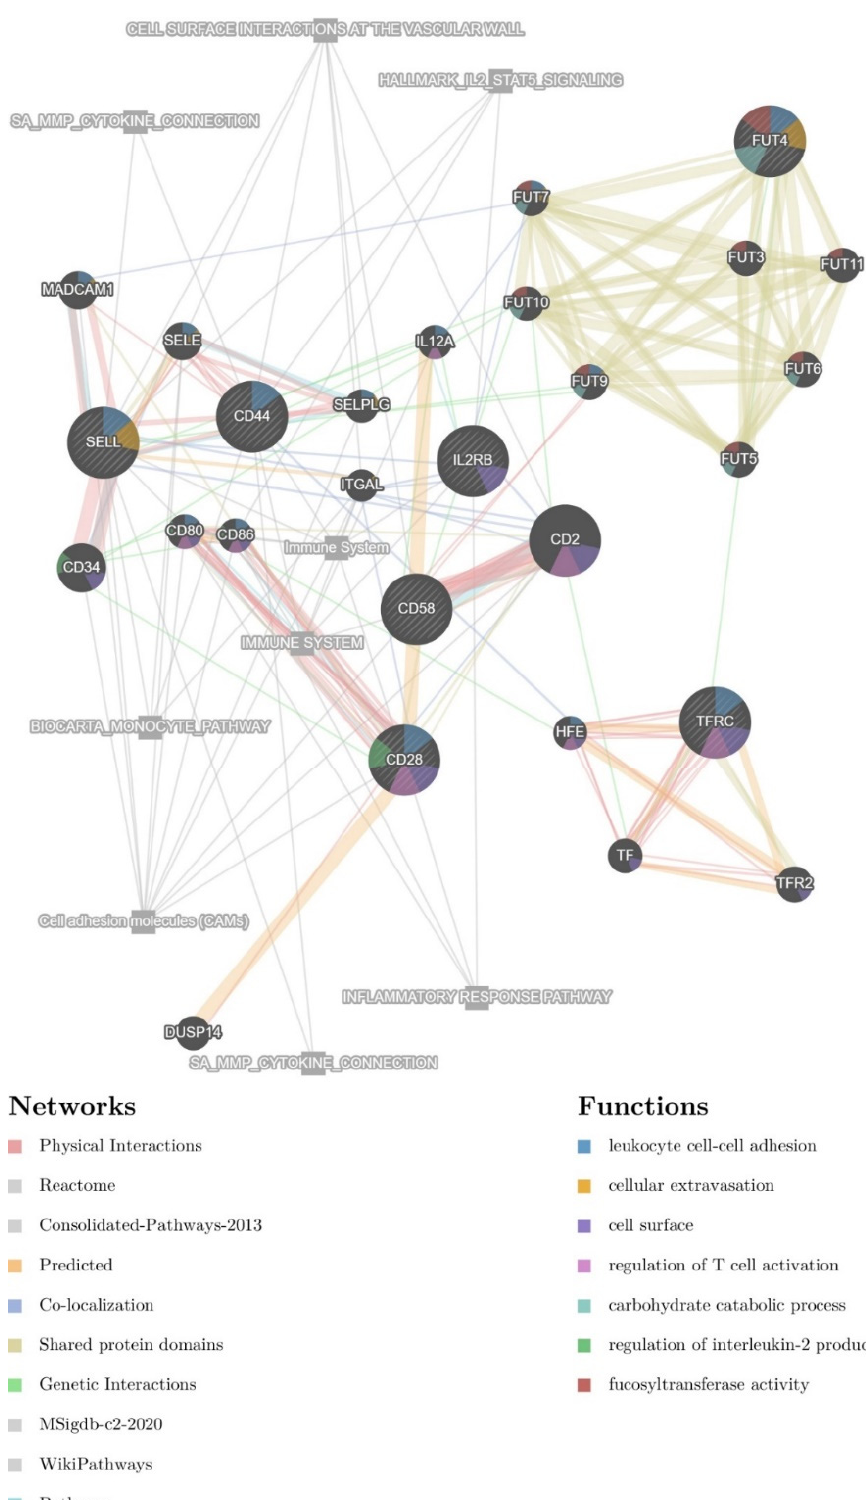
Figure 2. Interaction network containing surface markers that are targeted by NF- κ B. The nodes indicate interaction. The color of each node designates a different type of interaction, explained in the bottom-left corner legend. Associated functions are designated with a colored pie chart within the respective circles representing individual proteins, explained in the bottom-right corner legend.